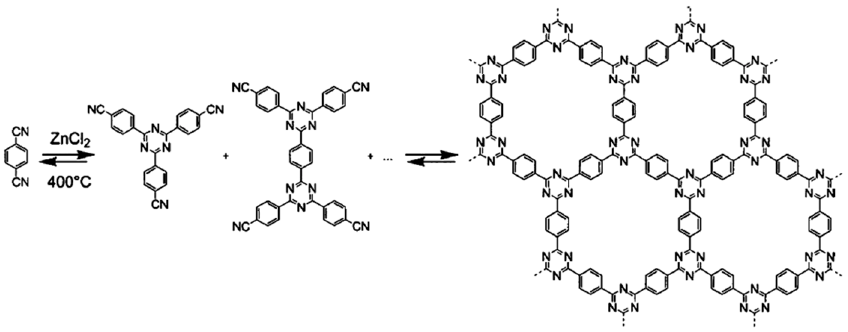
Figure 3. Polymerization of CTF-1 from the monomer 1,4-dicyanobenzene via ionothermal synthesis [17].